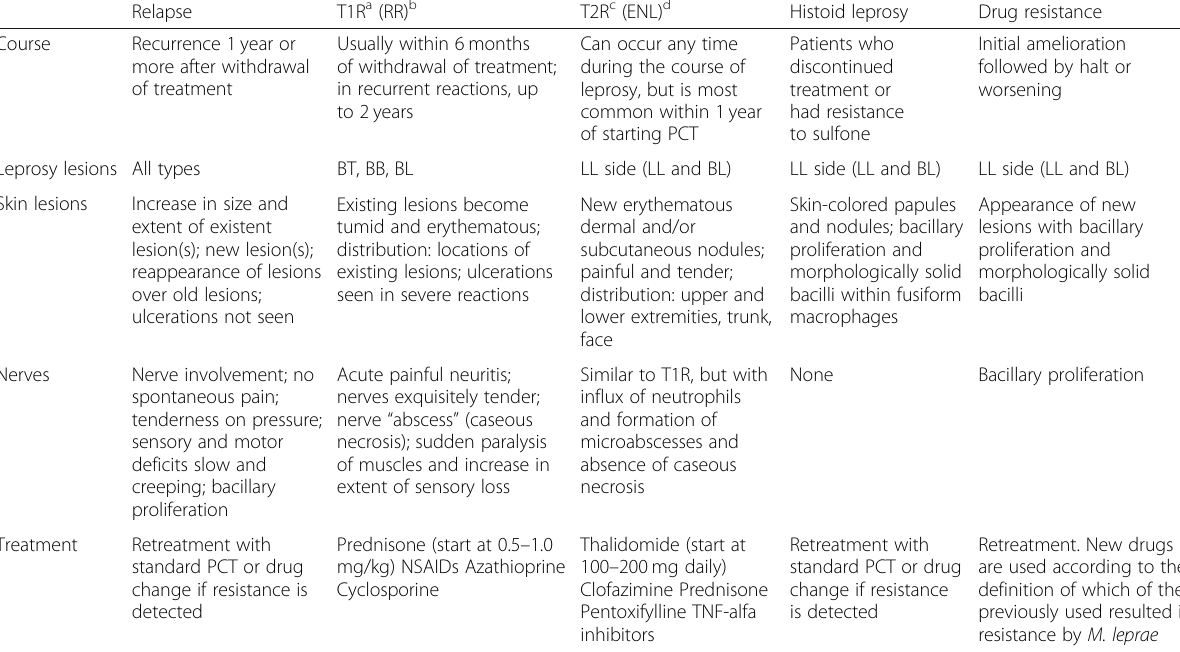
Table 2 Clinical and histopathological characteristics of the main leprosy lesions considered as diagnostic hypotheses that resulted in biopsies with a subsequent diagnosis of dermatofibromas originating in leprosy lesions